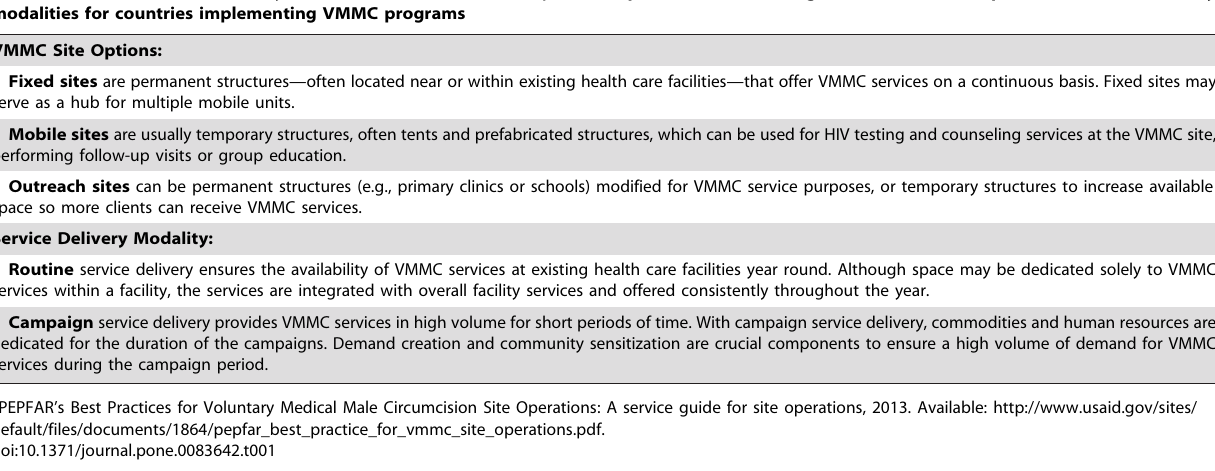
PEPFAR’s BestPracticesforVoluntaryMedicalMaleCircumcisionSiteOperations* provides the following definitions for site options and service delivery modalities for countries implementing VMMC programs VMMC Site